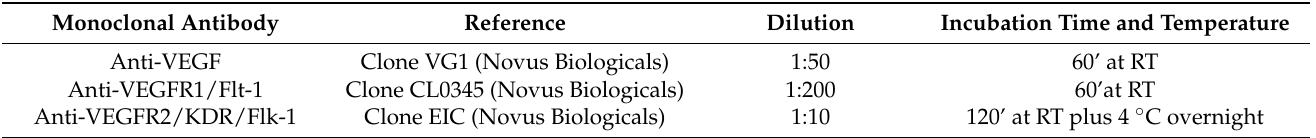
Table 2. Primary antibodies and their conditions of use.